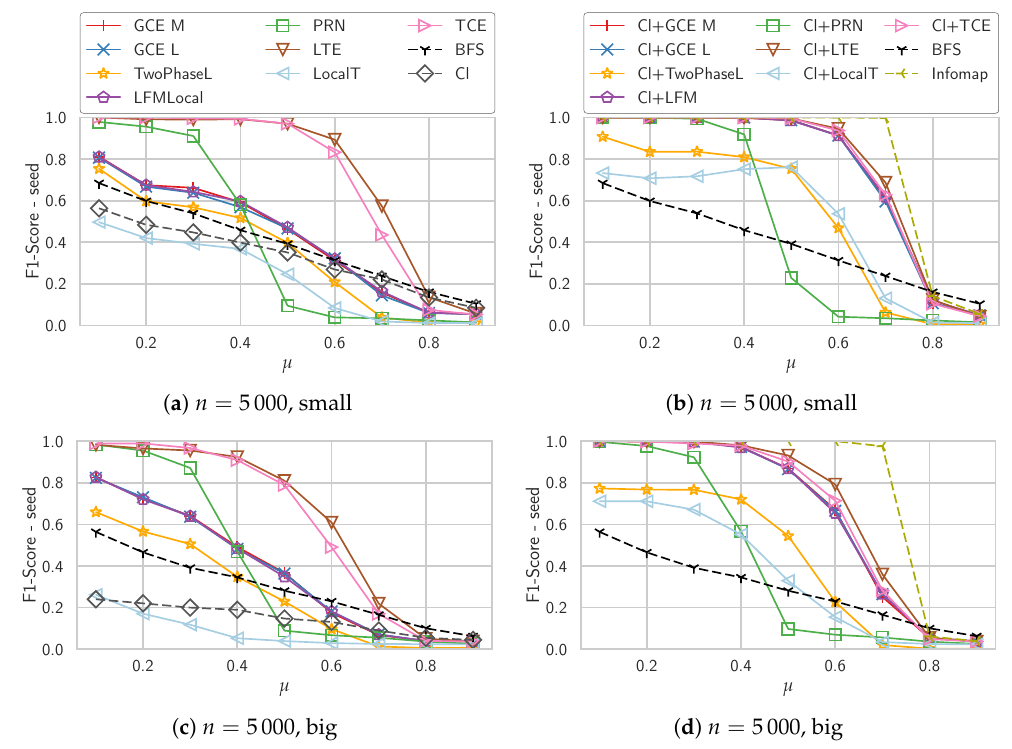
Figure 1. Avg. F 1 -scores on the LFR benchmark with the parameter set Unweighted, which we specify in Table 1. The left column shows results when starting with a single seed node, the right column shows results for starting with the maximum clique as well as Infomap for